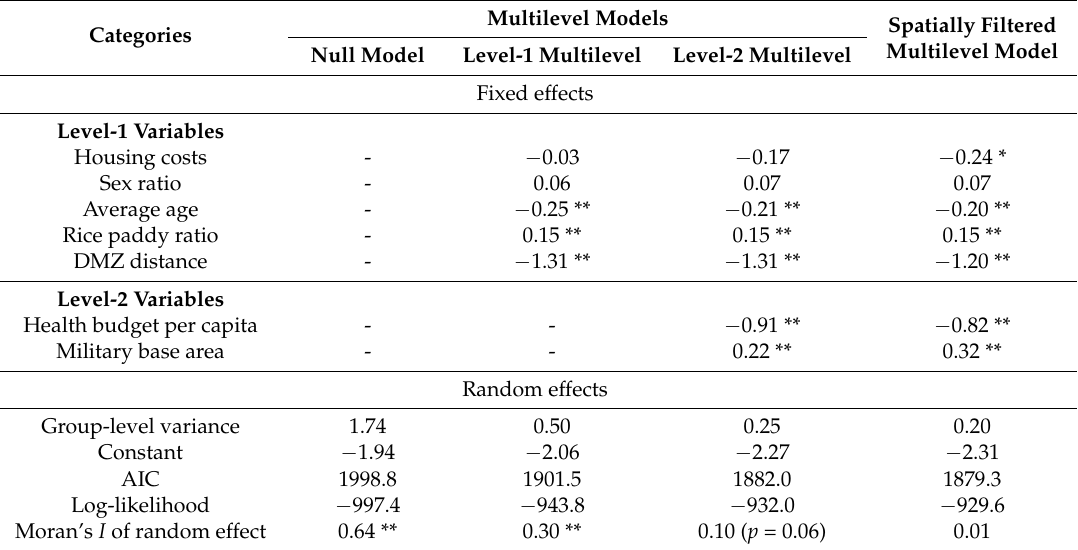
Table 2. Estimation results of the